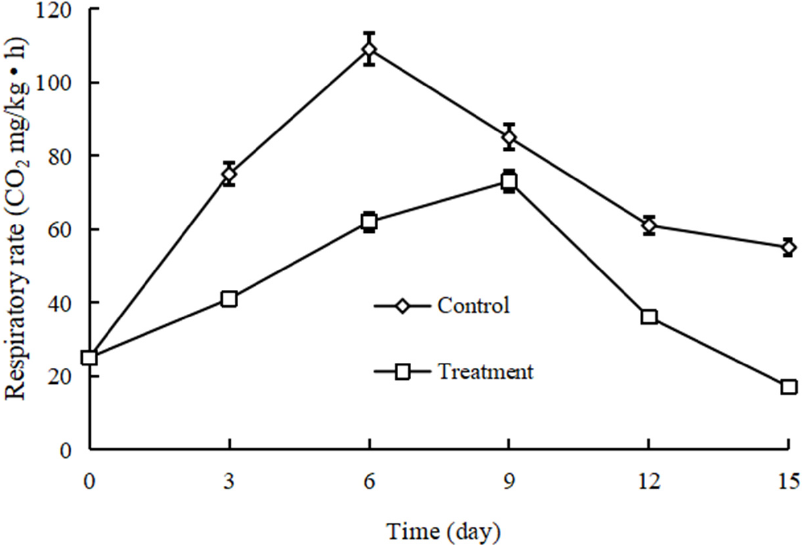
Figure 4. Effect of pullulan-based coatings on the respiratory rate of cowpeas during refrigerated storage. Bars represent the standard deviation ( n = 6).